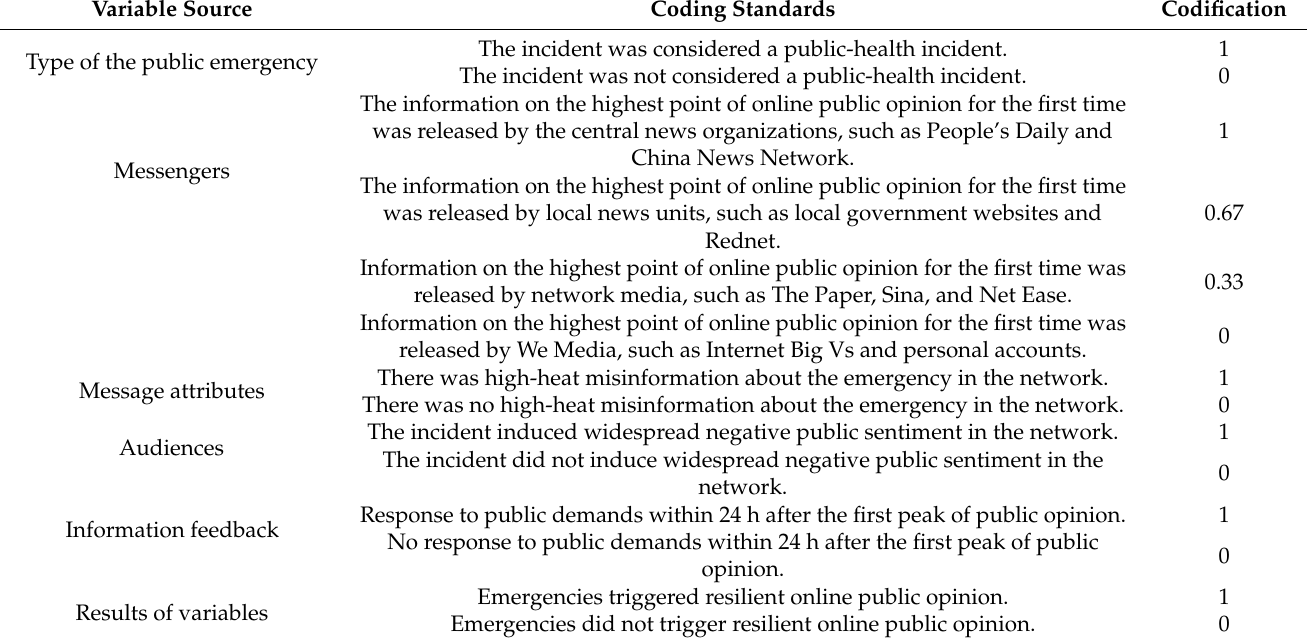
Table 1. Settings of results and condition